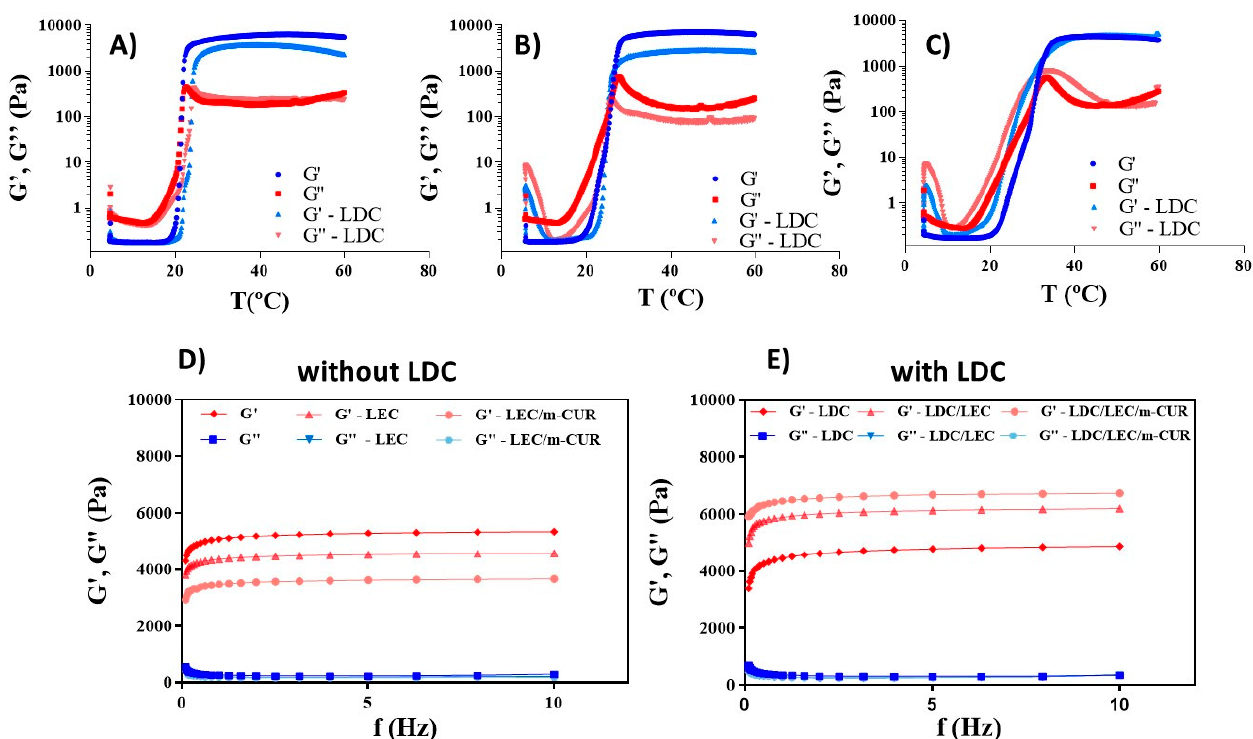
Figure 4. Representative sol–gel transition temperature rheograms: ( A ) ORG and ORG-LDC, ( B ) ORG-LEC and ORG-LDC/LEC, and ( C ) ORG-LEC/m-CUR and ORG-LDC/LEC/m-CUR; rheological frequency sweep analysis for the ORGs formulations ( D ) without LDC and ( E ) with LDC.